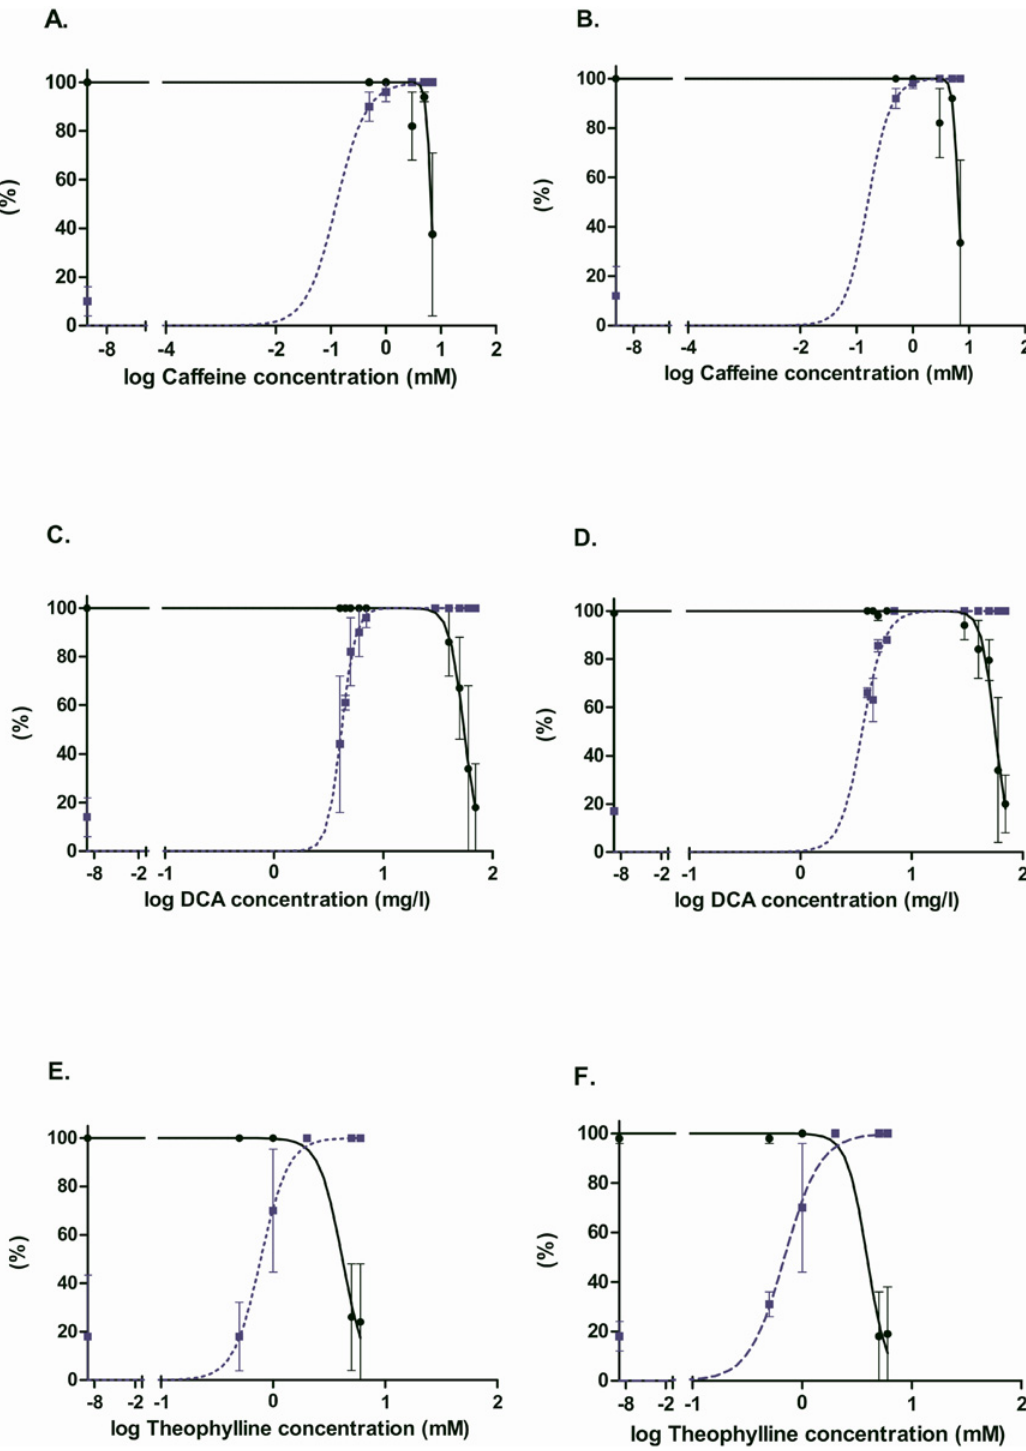
Figure 4. Dose-response curves for caffeine, theophylline and DCA. Survival and morphological defects of larvae intoxicated from 2dpf to 3dpf. The fraction of surviving larvae is represented by the “ Survival ” curve on each graph by a LC50 curve. The EC50 (teratogenicity) curve is drawn according to the results given by the “ Normal ” phenotype, as the fraction of surviving larvae. A, C, E graphs have been obtained on the basis of manual observations, whereas B, D and F graphs are based on automatic analysis.